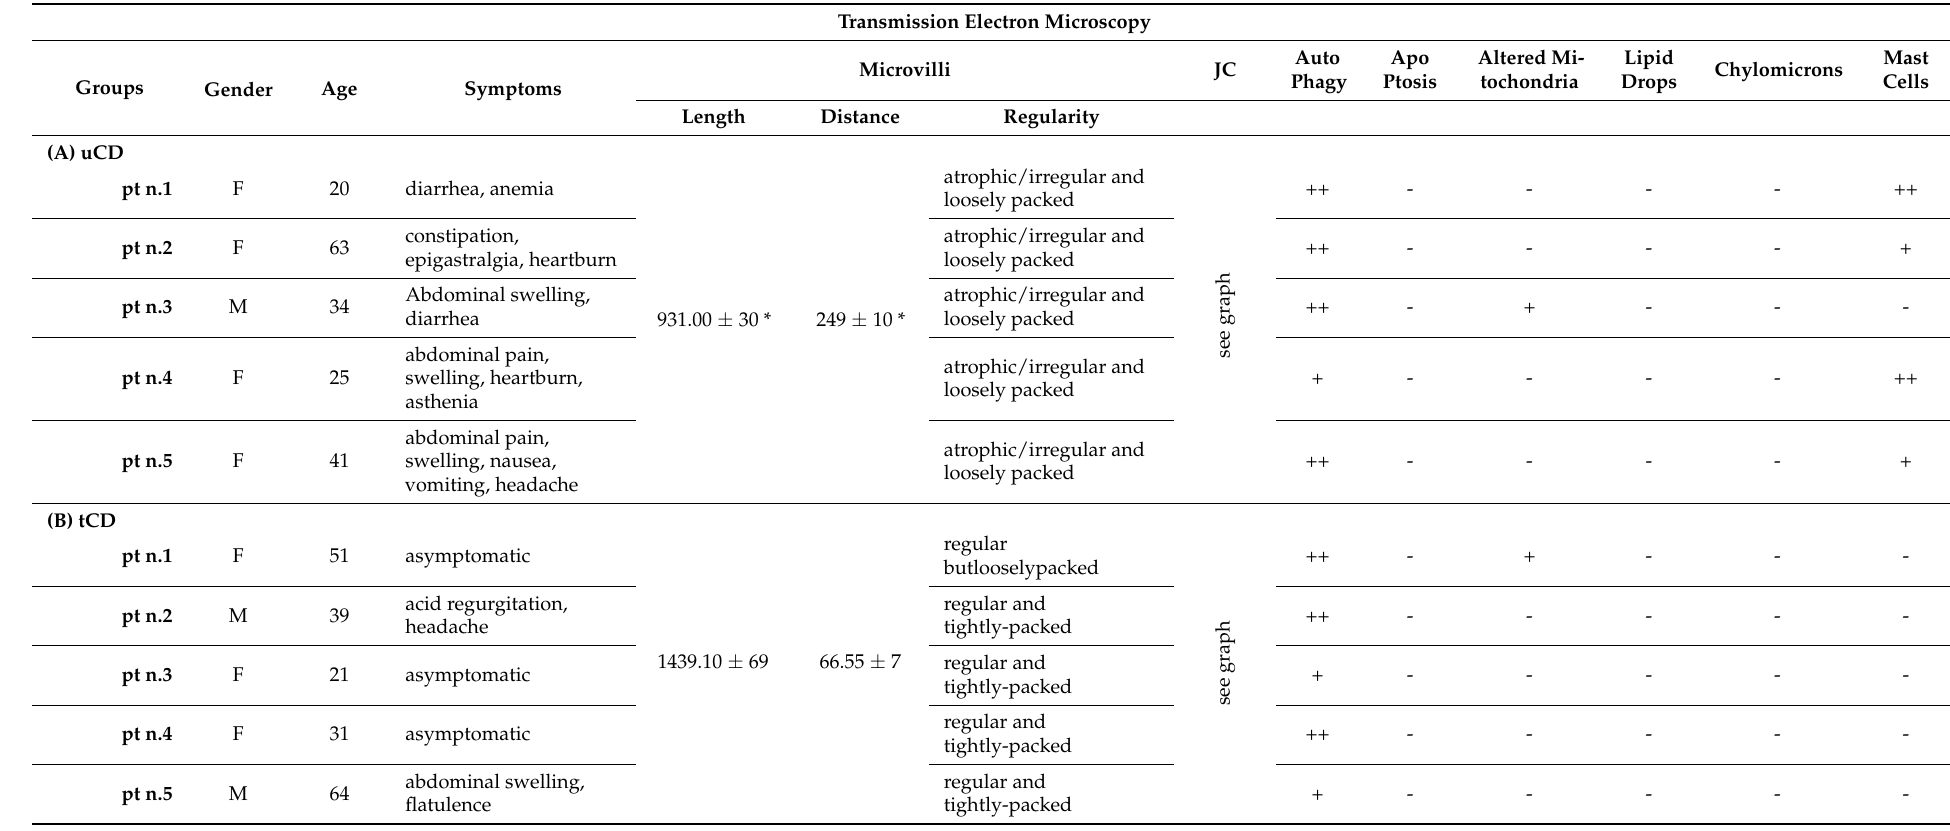
Table 2. Ultrastructural evaluation by electron microscopy of duodenal biopsies in IBS-like patients A qualitative score (++ = marked presence; + = presence; - = absence) was provided for widened junctional complexes, autophagy, apoptosis, altered mitochondria, lipid drops, chylomicrons, and mast cells. Legend: CTRL, control patients; JC, junctional complexes; NCGS, non-celiac gluten sensitivity; Ni ACM, Nickel allergic contact mucositis; tCD, treated celiac disease; uCD, untreated celiac disease; WA, wheat allergy. * microvilli length and inter-microvillar distance in uCD patients have been measured in those portions of epithelium surface not involved by total microvillar